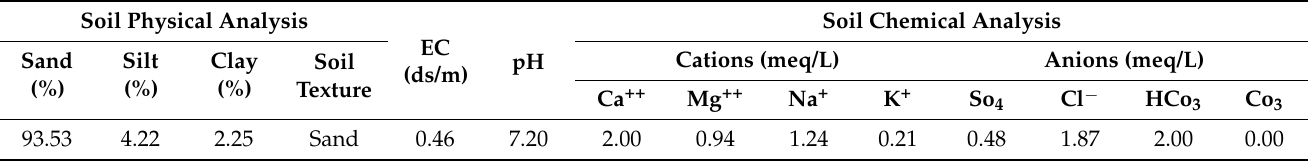
Table 1. Physical and chemical properties of the experimental farm soil.